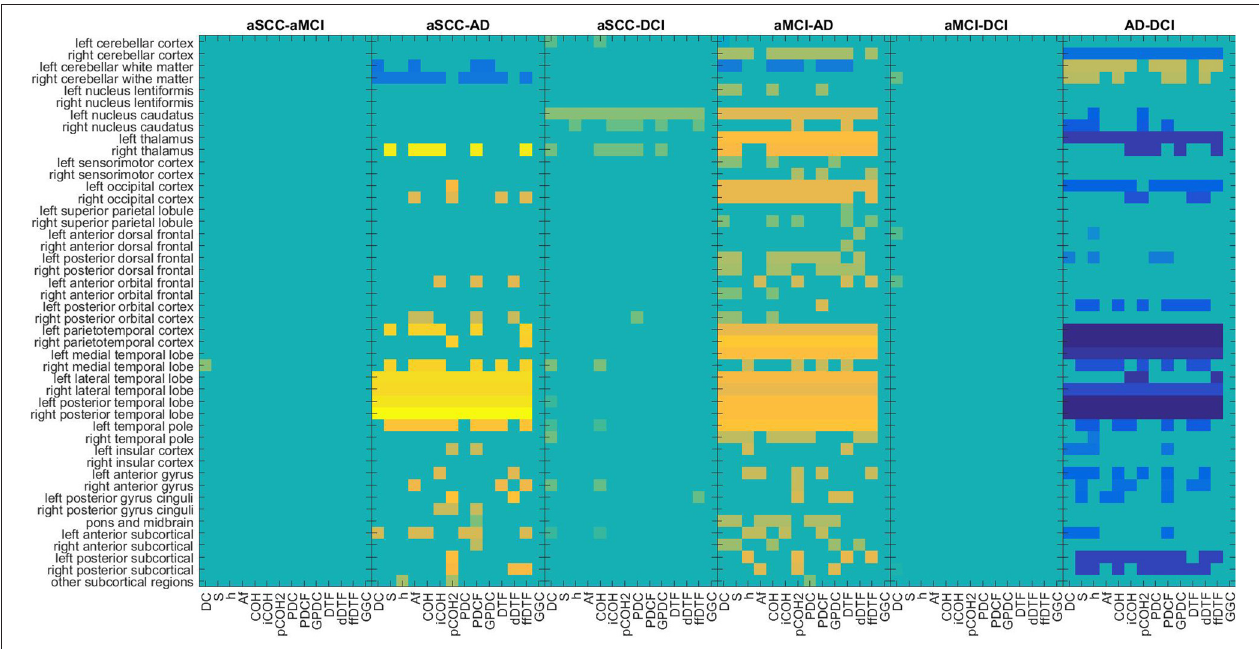
FIGURE 4 | Maps of the t -values of group differences of all regions of interest assessed by SPECT perfusion, sorted by groups comparisons, colored according to use for classification in combination with EEG measures. Colors indicate values from − 4.95 (dark blue) over zero (green) to + 6.07 (yellow). All values that were not included for classification were set to zero. If the first group of the group comparison (e.g., aSCC in aSCC-aMCI) has higher values than the second group, this results in a positive t -value, i.e., yellow colors. For each measure (columns of subplots) only those regions (rows of subplots) were colored according to the t -values that were used for classification. AD, Alzheimer’s disease; DCI, depression with cognitive impairment; aMCI, mild cognitive impairment with amnestic symptoms; aSCC, subjective cognitive complaints with amnestic